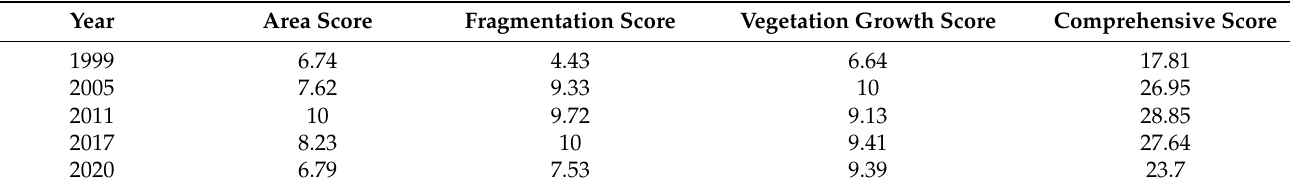
Table 6. Bird habitat rating table in beaches from 1999 to